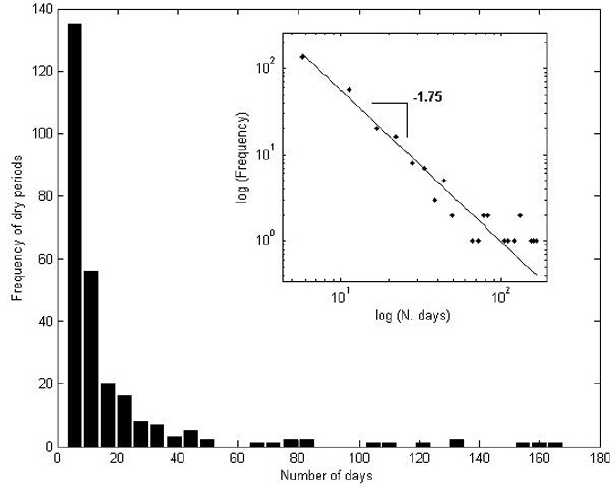
Fig. 5. Interannual and seasonal (inset figure) variability of dust occurrences over the Canaries during the period 1989–2010 (METARs).